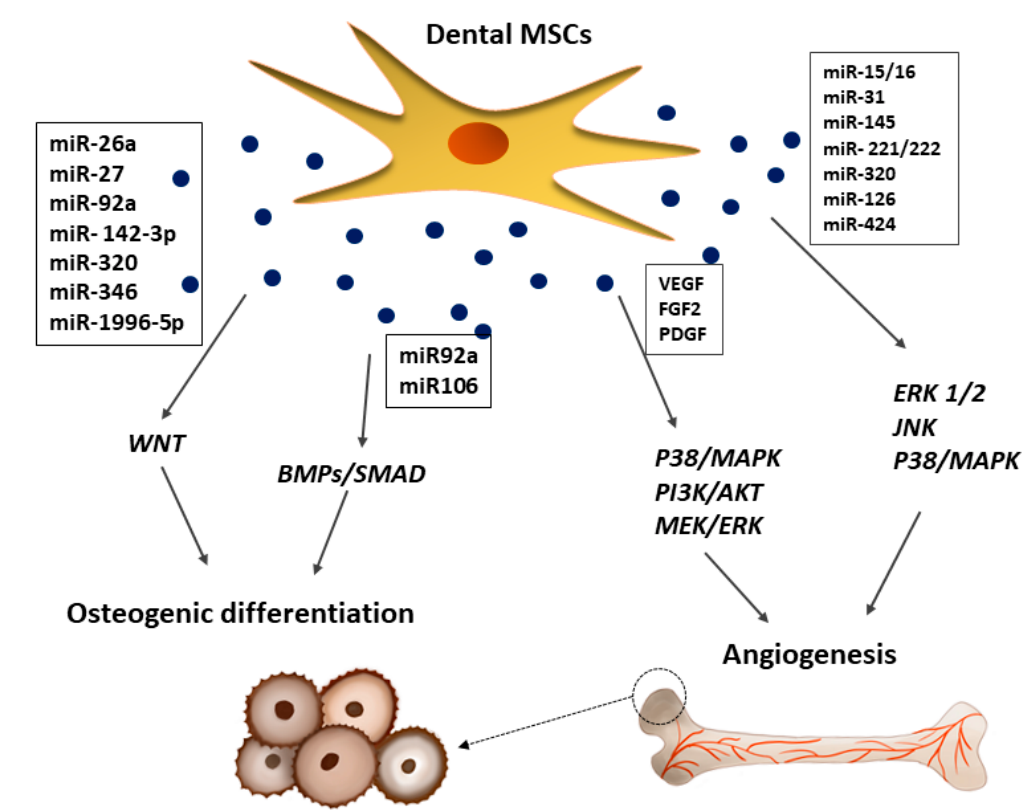
Figure 5. Effects of dental MSC-derived secretome in bone repair. Dental MSC-EVs promoted bone formation and osteoblast differentiation through the activation of BMPs/SMAD and WTN signaling pathways, whereas, VEGF and FGF2 released from dental MSCs promoted formation of new blood vessels by activation of p38/MAPK, PI3K/AKT, and MEK/ERK signaling